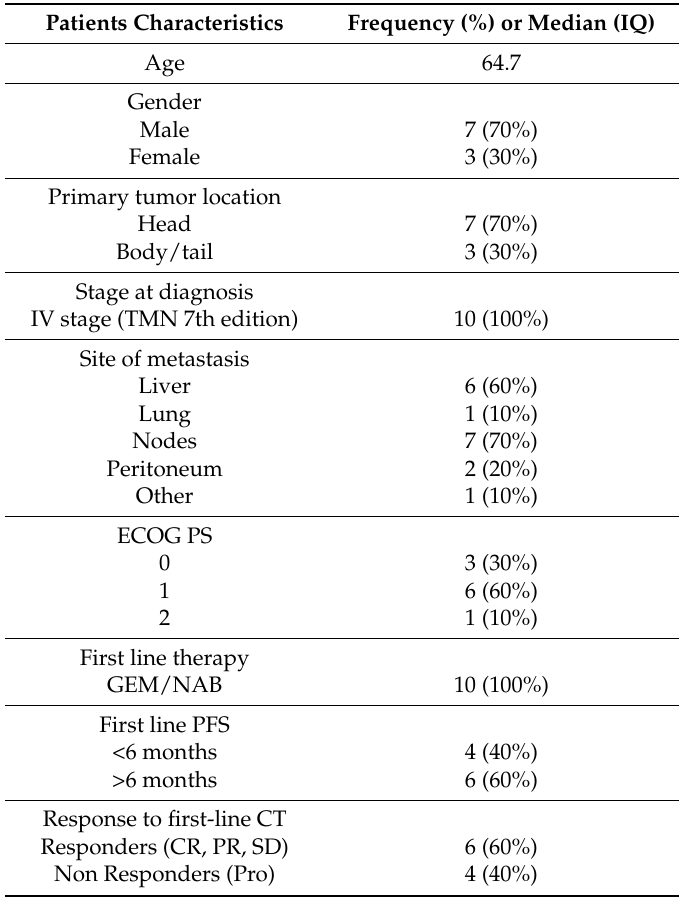
Table 2. Patients Characteristics ( n =